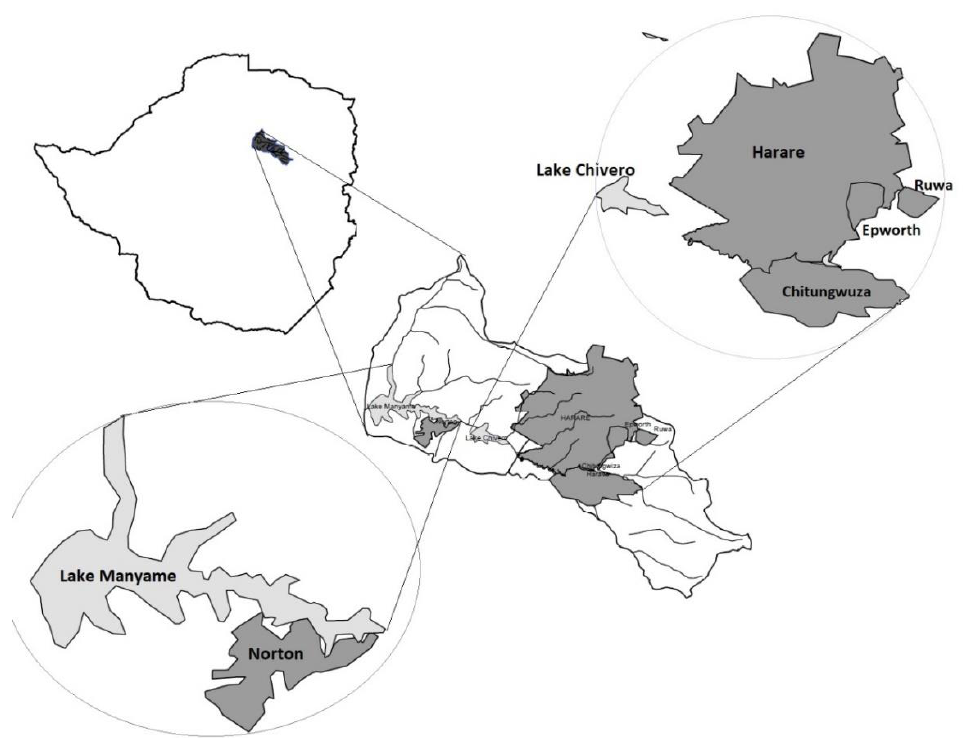
Figure 1. Location of the study area.